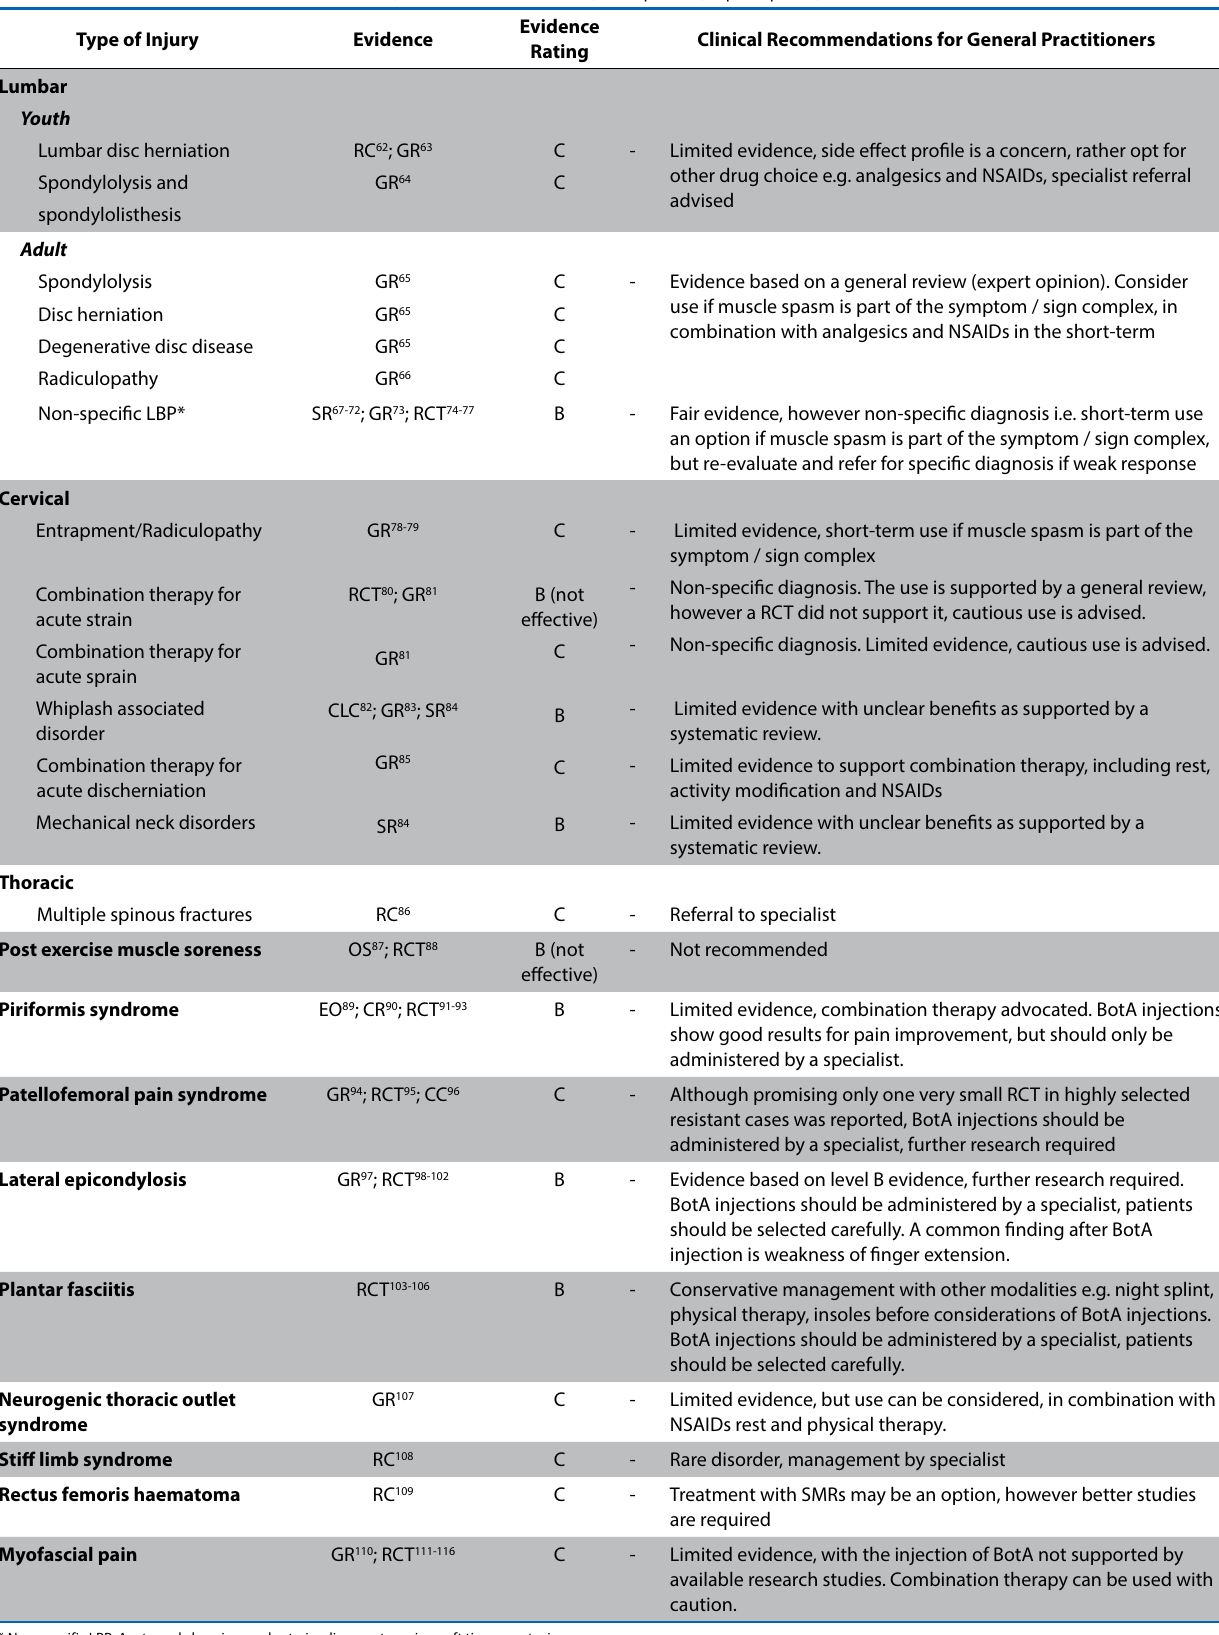
Table 4: Clinical recommendations for general practitioners based on SORT (Strength of Recommendation Taxonomy 61 ) A: consistent, good-quality patient-oriented evidence B: inconsistent or limited-quality patient-oriented evidence C: consensus, disease-oriented evidence, usual practice, expert opinion, or case